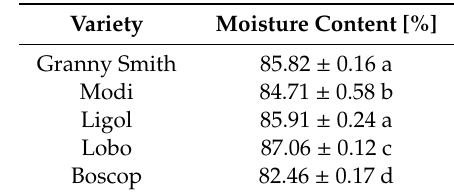
Table 1. Moisture content in fresh apples depending on the